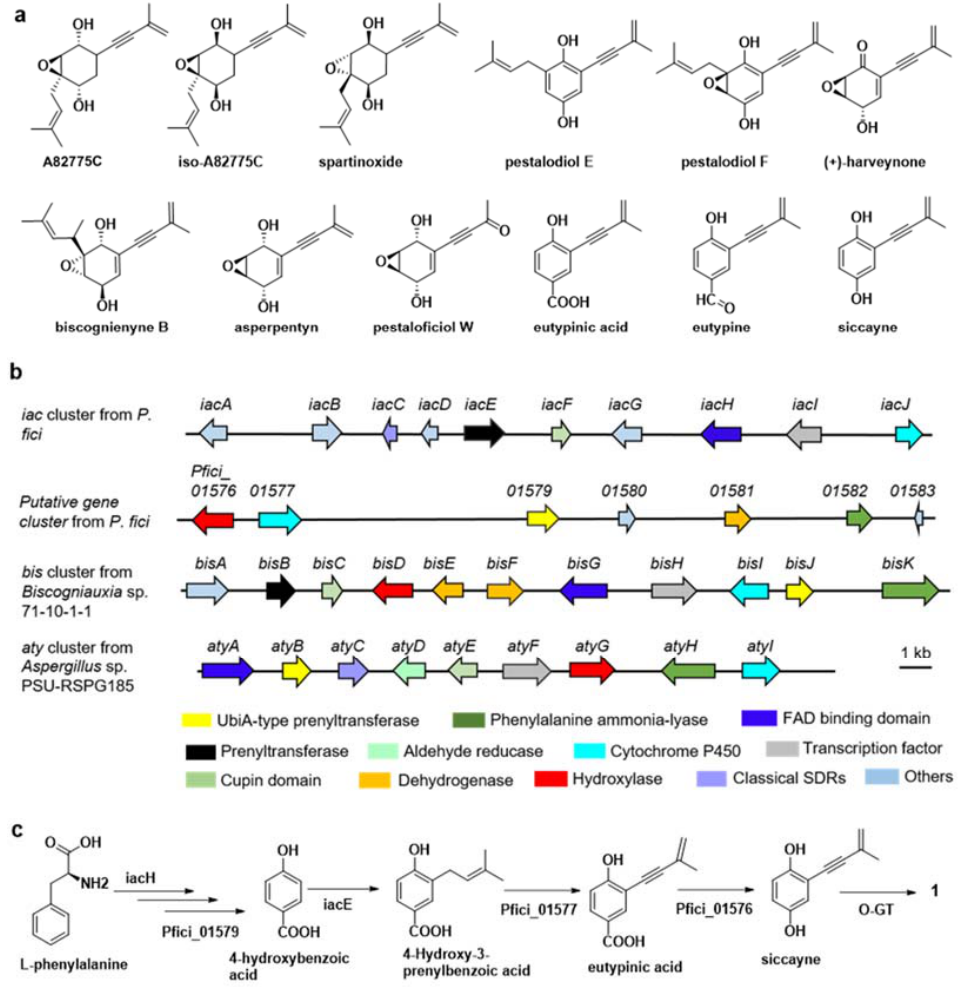
Figure 3. The structure analogues with alkynyl of 1 and biosynthesis of 1 . ( a ) The structure analogues of 1 produced in filamentous fungi; ( b ) the gene clusters related to biosynthesis of siccayne and 1 in filamentous fungi; ( c ) proposed biosynthetic pathway for 1 in P. fici .